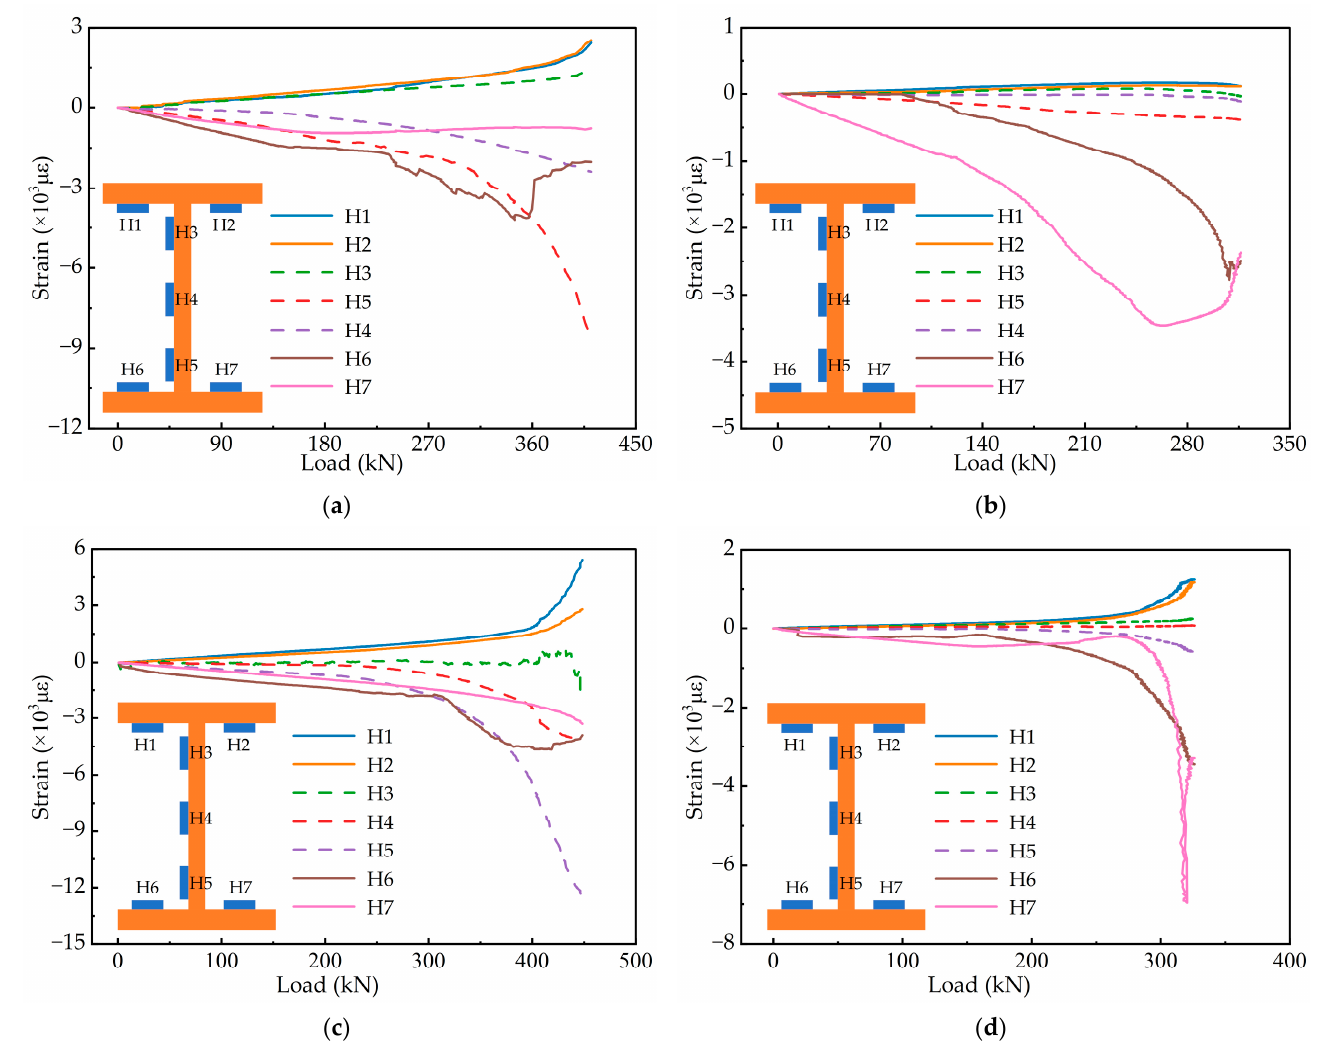
Figure 8. Strain development of the steel girder: ( a ) specimen SNF; ( b ) specimen SNC; ( c ) specimen SEF; ( d ) specimen SEC.